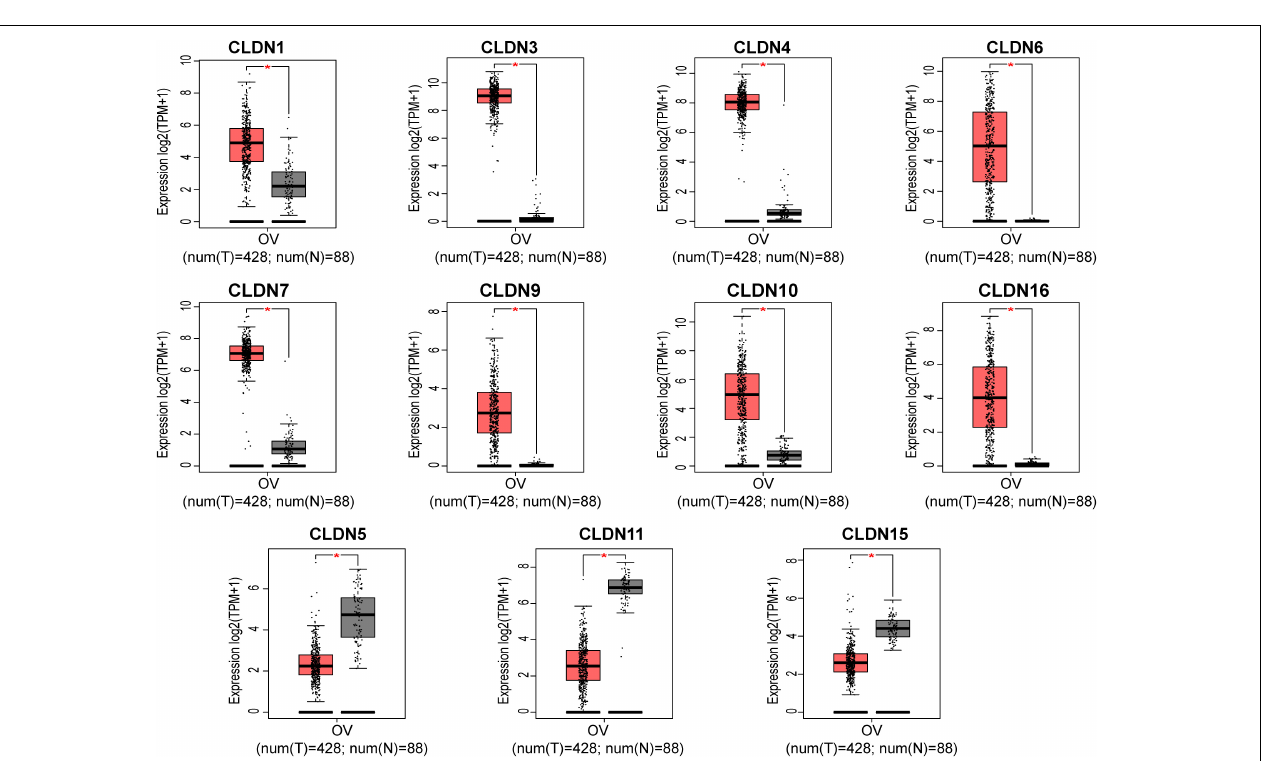
FIGURE 2 | The mRNA expression of claudins in TCGA samples and the GTEx normal samples via GEPIA2. (* p < 0.01).